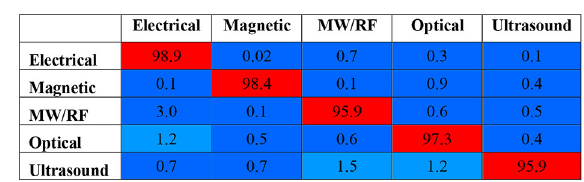
FIGURE 2 | Heat map of percentage of common patents between domains. A diagonal cell shows the percentage of patents in a focal domain (e.g., 97.3% for optical stimulation in the fourth row) that are not common with any of the other domains. The off-diagonal cell indicates the percentage of patents in a focal domain common with another domain (e.g., 0.6% for optical stimulation with Microwave/RF